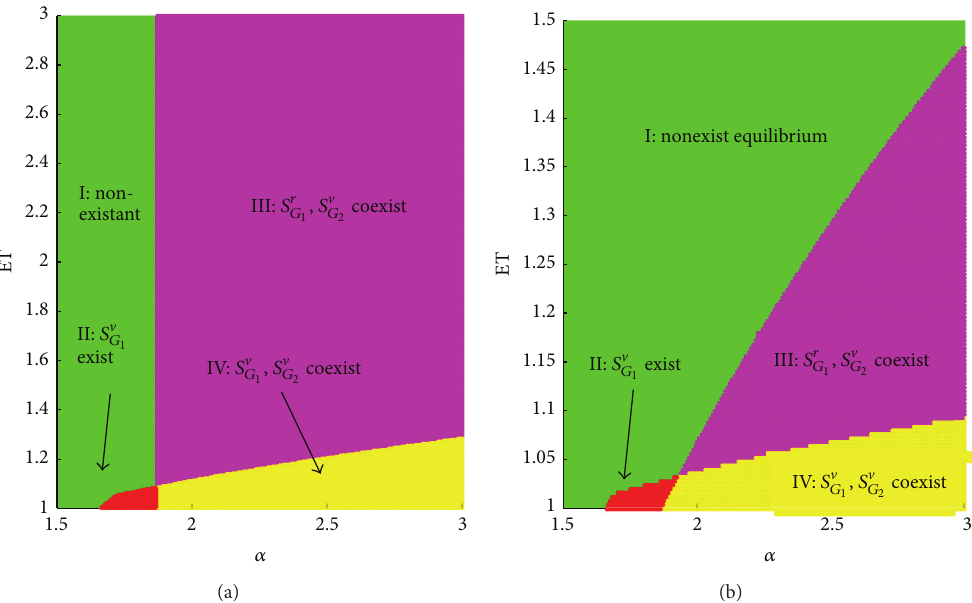
Figure 1: Parameter bifurcation diagram for the existence of equilibria of system (3). Here we choose 𝛼 and ET as bifurcation parameters and fix others as follows: 𝑃 = 0.1 , 𝑘 = 1 , 𝜏 = 0.5 . (a) 𝛼 ∈ [1.6, 2.9] , ET ∈ [1, 3] , and 𝛽 = 3 ; (b) 𝛼 ∈ [1.6, 2.9] , ET ∈ [1, 3] , and 𝛽 ∈ [1,4] , simultaneously. Region I (green): nonexistent equilibria; region II (red): 𝑆 V 𝐺 𝑆 V 𝑆 V 𝐺 1 and 𝐺 2 coexist.